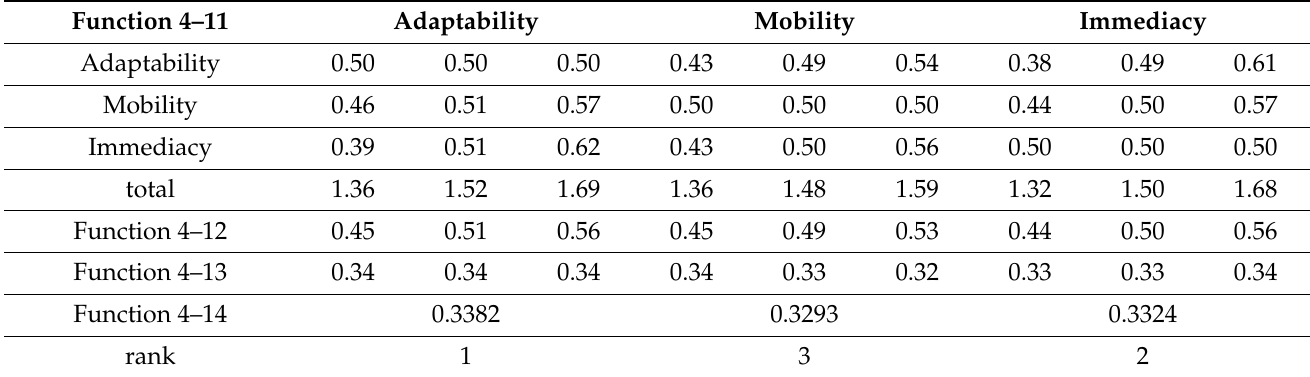
Table A11. Travel agencies’ weights of attributes of the conditional value.